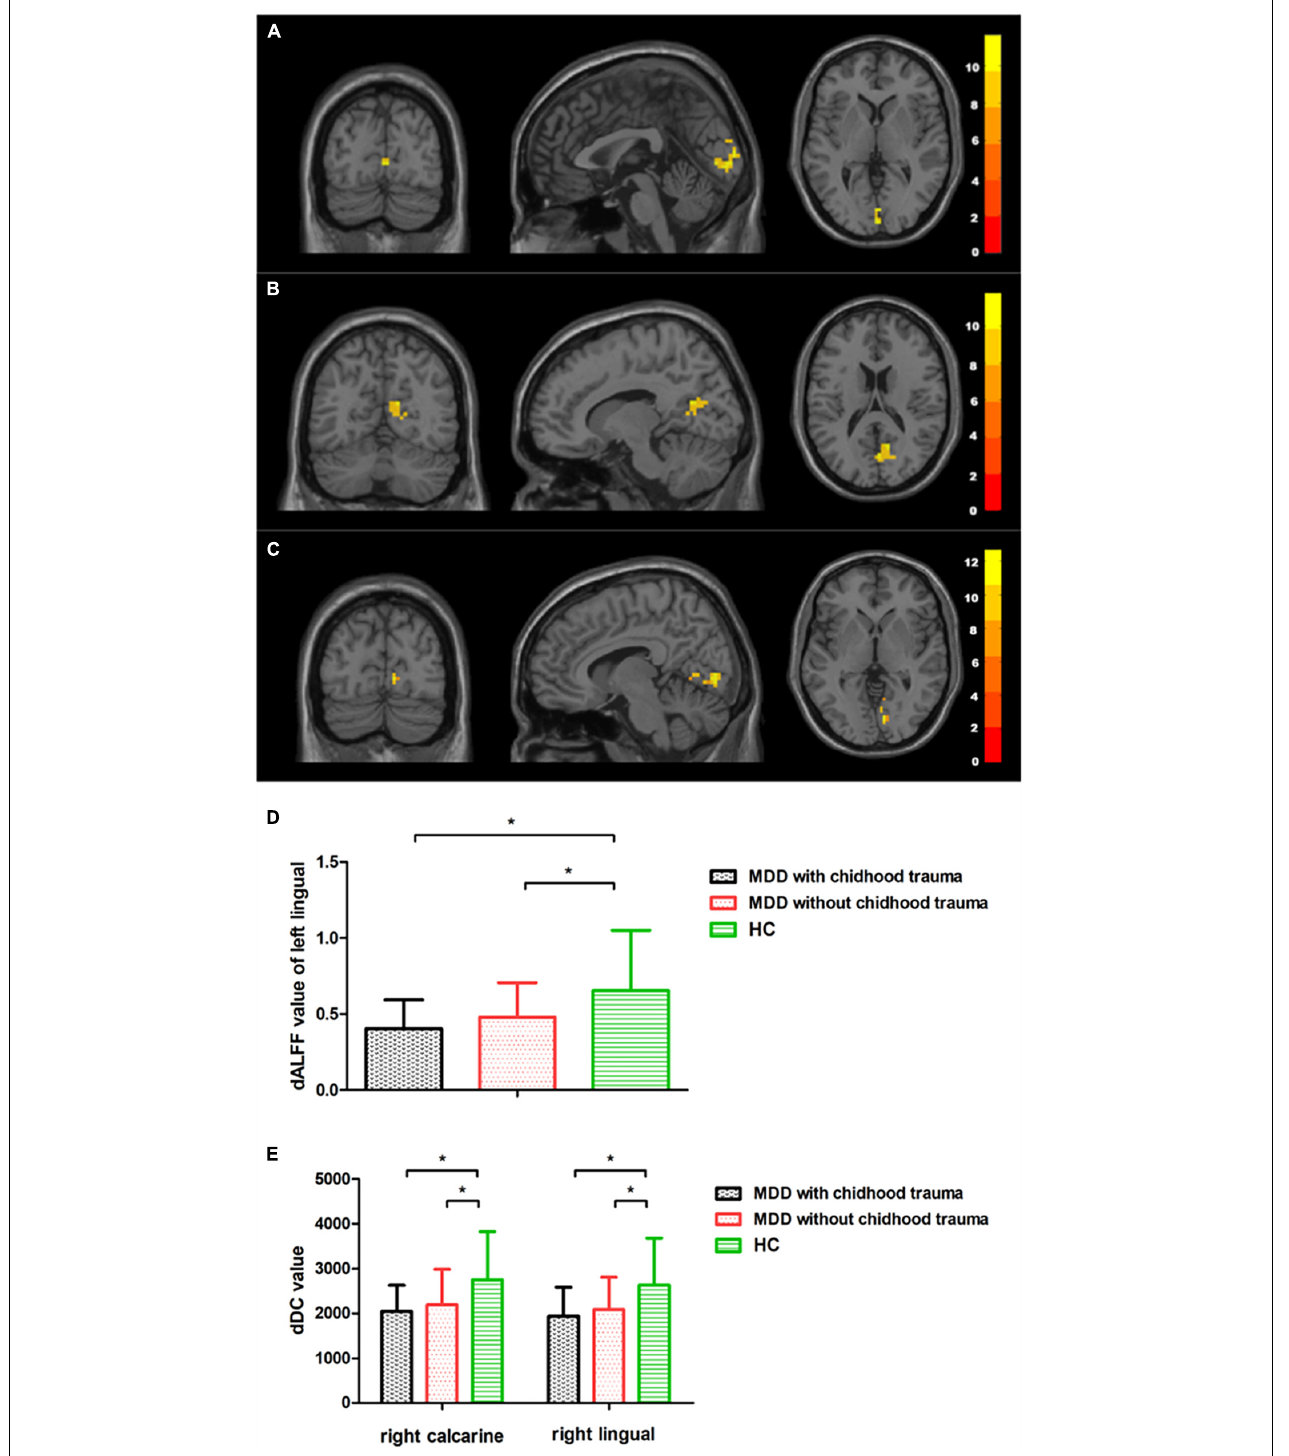
FIGURE 1 | Regions with differences in dALFF and dDC between the MDD with childhood trauma, MDD without childhood trauma, and HC groups and post hoc analysis. (A) The intergroup difference in dALFF in the left lingual gyrus. (B,C) The intergroup difference in dDC in the right lingual gyrus and the right calcarine cortex, respectively. (D,E) The multiple comparisons in regions with differences in dALFF and dDC, respectively. MDD, major depressive disorder; HC, healthy control; dALFF, dynamics of amplitude of low-frequency fluctuations; dDC, dynamics of degree centrality. * means the p -value has reached a significant level. In the multiple comparisons in regions with differences in dDC, p < 0.05/1 = 0.05 was accepted as significant. In the multiple comparisons in regions with differences in dDC, p < 0.05/2 = 0.025 was accepted as